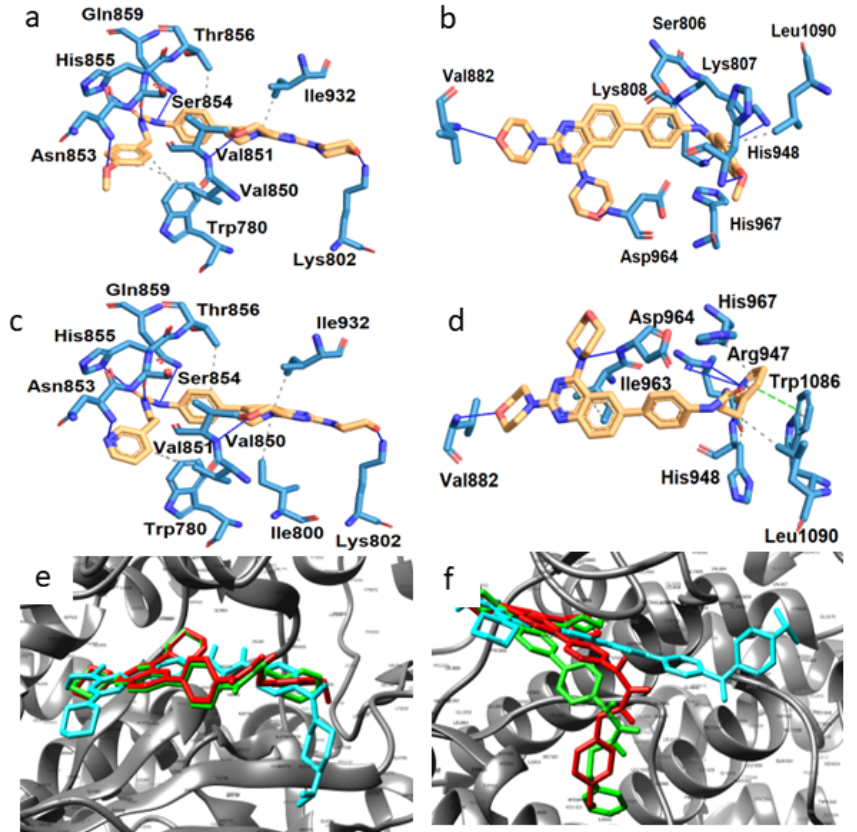
Figure 12. Docking of the compounds 7b ( a , b ) and 7c ( c , d ) into the catalytic site of PI3K α ( a , c ) and PI3K γ ( b,d ). The gray dotted line is hydrophobic interactions, the blue solid line is hydrogen bonds, the light green dotted line is parallel π‐π stacking, dark green dashed—normal π‐π stacking. yellow dotted line—salt bridge. Pictures 5E and 5F represent a superposition of 7b , 7c and Gedatolisib 8 in the catalytic site of PI3K α ( e ) and PI3K γ ( f ). Gedatolisib ( 8 ) is colored in blue, 7b— red and 7c— green. Visualization of the docking results (protein ‐ ligand complexes) was carried out using the PLIP service. The superposition of ligands was visualized via UCSF Chimera program. Table 2. Docking results of the selected compounds and gedatolisib into catalytic sites of PI3K α and PI3K γ .